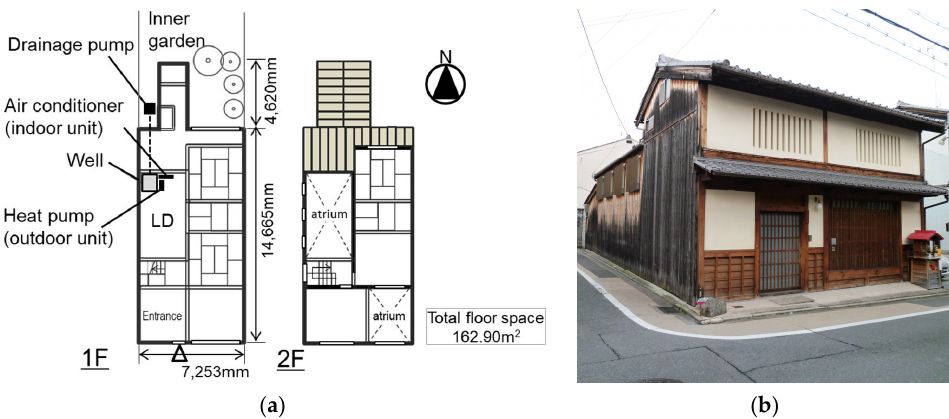
Figure 1. Surveyed Kyo-machiya home: ( a ) floor plan and ( b ) exterior image.